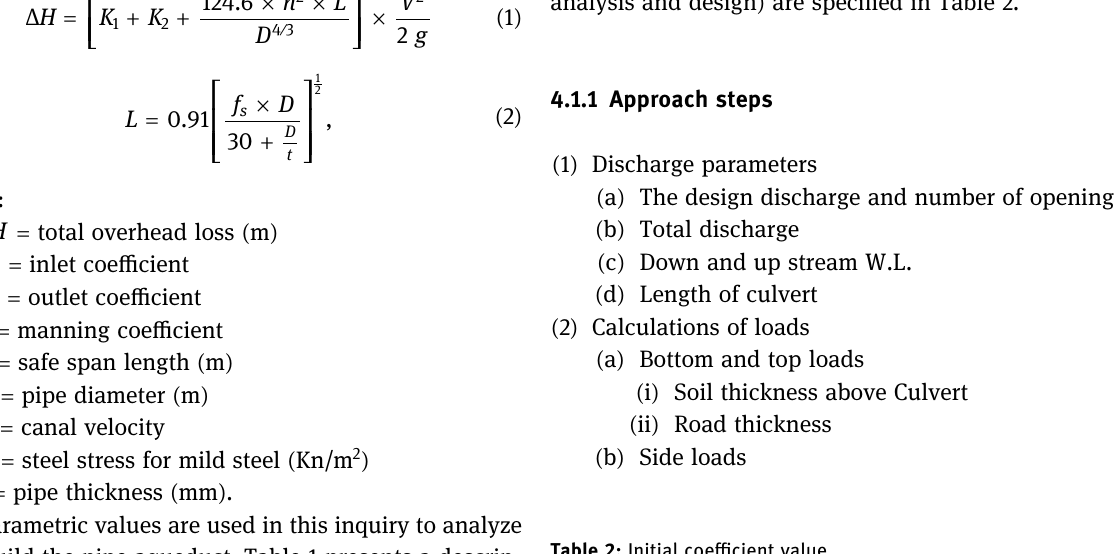
Table 2: Initial coe ffi cient value Design discharge